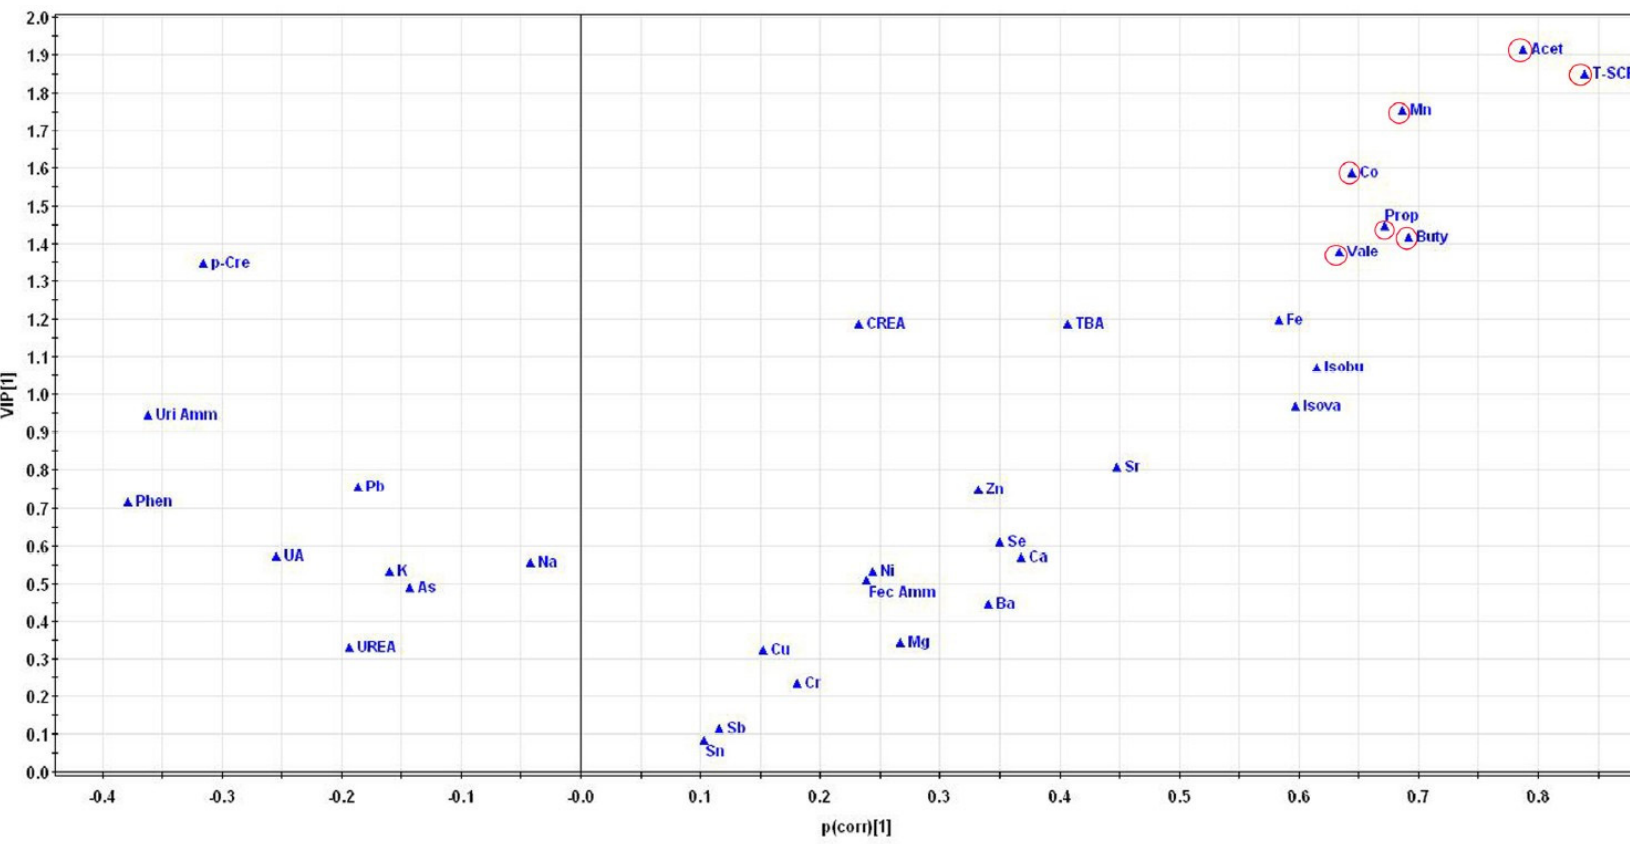
Figure 5. V plot of the partial least squares-discriminant analysis of overall indexes including the metabolites and elements in the three groups. Each triangle denotes an individual component. The triangles far away from the origin represent the components responsible for the differences among the three groups. The acetic acid, total SCFA, Mn, Co, propionic acid, butyric acid and valeric acid are the farthest away from the origin in the V plot, which further indicates that they are the differential components obtained from the PLS-DA model. Acet, acetic acid; Prop, propionic acid; Buty, butyric acid; Isobu, isobutyric acid; Vale, valeric acid; Isova, isovaleric acid; T-SCFA, total SCFA; TBA, total bile acids; Phen, phenol; p -Cre, p -cresol; UA, uric acid; CREA, creatinine; Fec Amm, fecal ammonia; Uri Amm, urinary